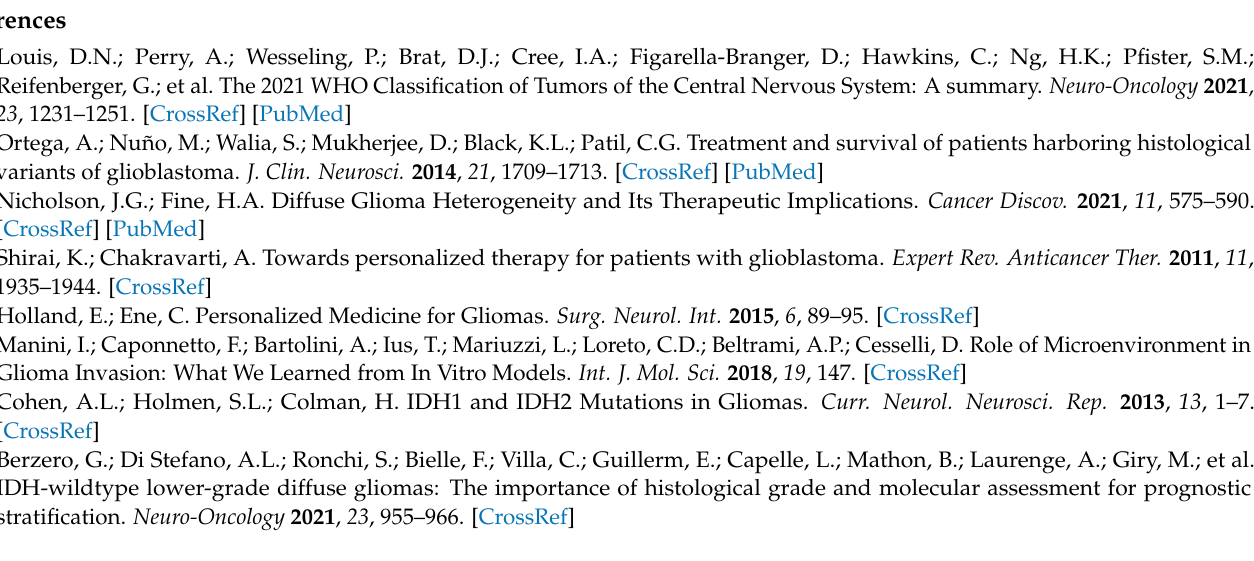
correlation type (blue and red for negative and positive correlations, respectively). Supplementary Data Table S4: Distribution of overexpressed and underexpressed neurotransmission-related genes in NT-1-4 gliomas, Supplementary Data Figure S5. Significant Gene Ontology group terms associated with system process, macromolecule localization, establishment of localization, regulation of biologi- cal quality, cellular component organization or biogenesis and cell communication gene level 3 gene ontology group terms. Colors represent the correlation type (blue and red for negative and positive correlations, respectively), Supplementary Data Table S5: Average expression levels of 73 differen- tially expressed miRNAs in NT-1-4 gliomas. Supplementary Data Table S6: Positive and negative correlations between CHRM1, CHRM3 and GRIN-1 genes and nonrelated neurotransmission genes. Supplementary Data Table S7: Comparison of immune cell type enrichment among NT-1-4 glioma clusters generated by the CIBERSORT analysis tool. Supplementary Data Table S8: Distribution